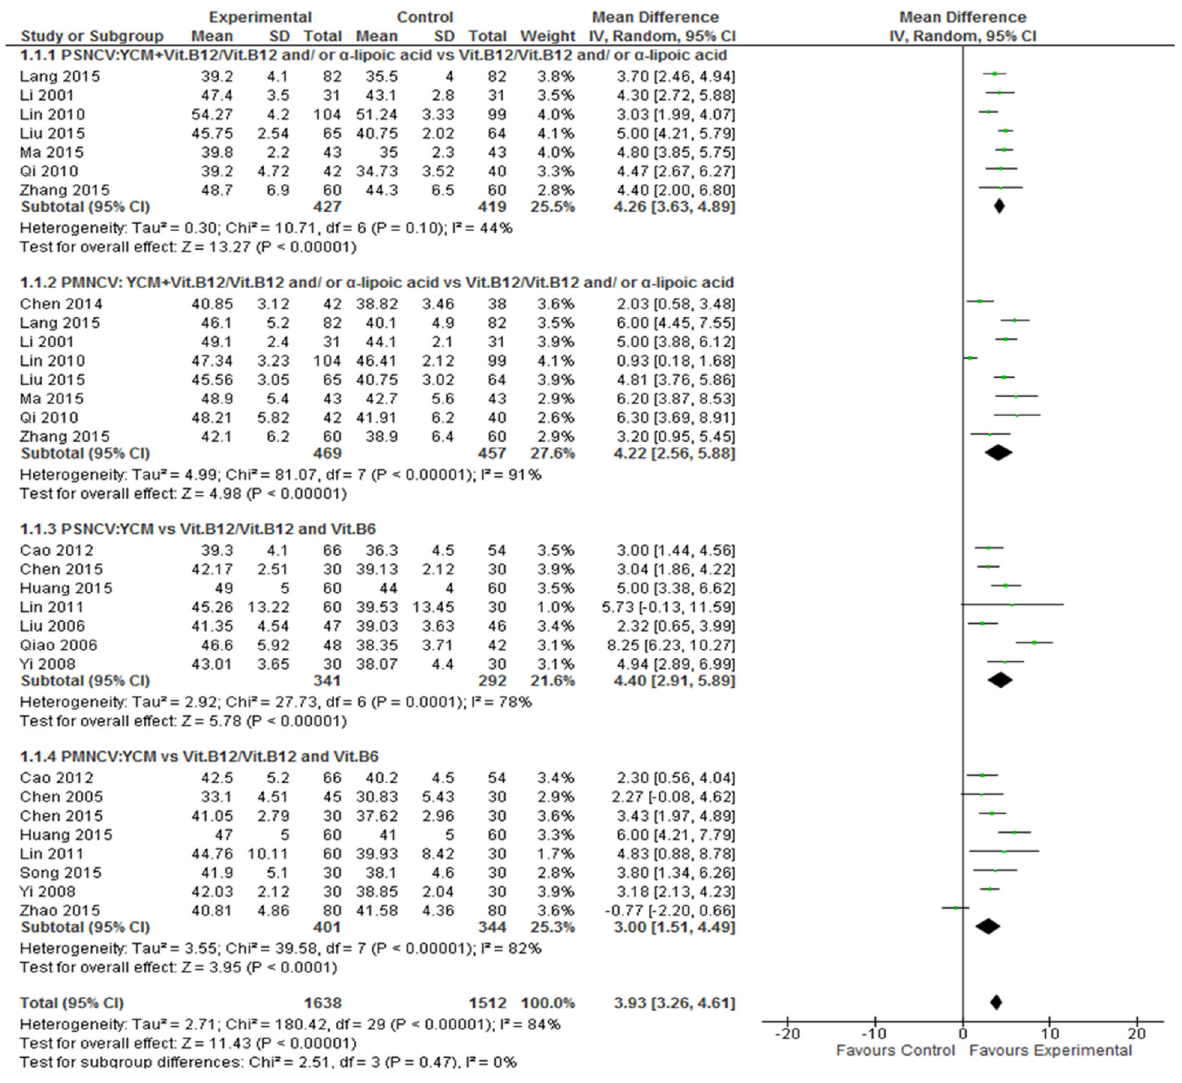
Fig. 2 Forest plot of peroneal nerve conduction velocity of YCM on diabetic peripheral neuropathy. Note: PSNCV: peroneal sensory nerve conduction velocity; PMNCV: peroneal motor nerve conduction